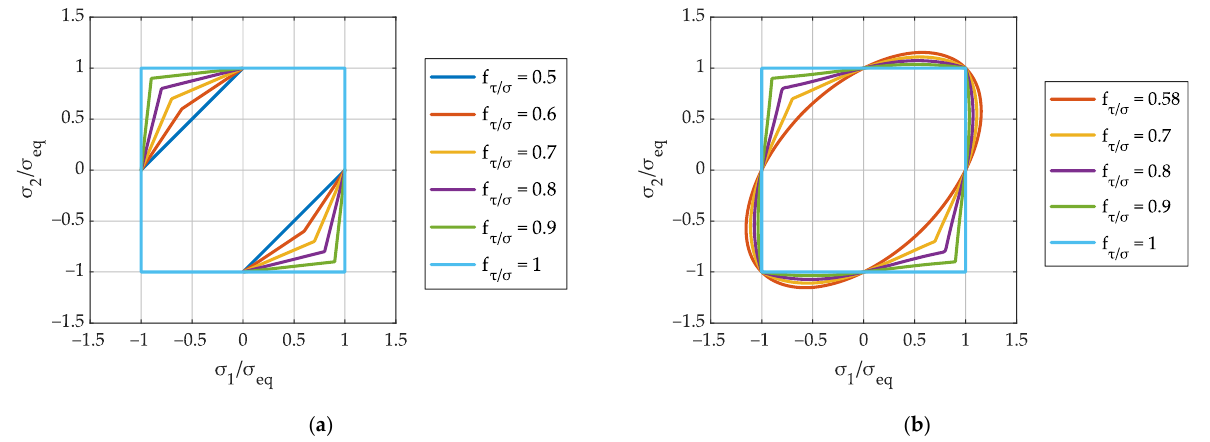
Figure 9. Strength hypothesis according to ( a ) Gaier and Dannbauer and ( b ) Riess et al. for plane stress states ( σ 3 = 0 ).